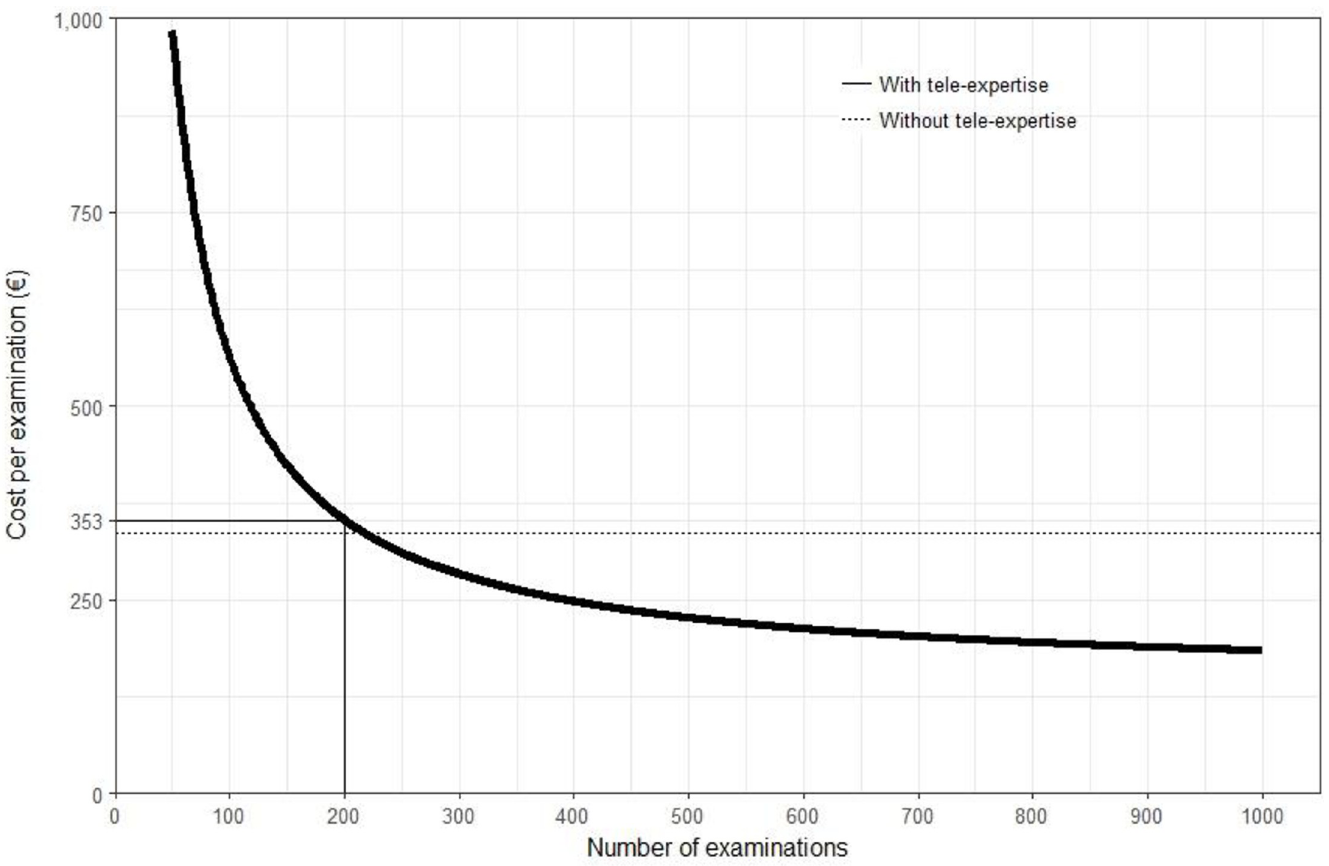
Fig 3. Overall cost of tele-expertise examination as a function of the number of requests (base case-cost curve)–CHSF medical center.